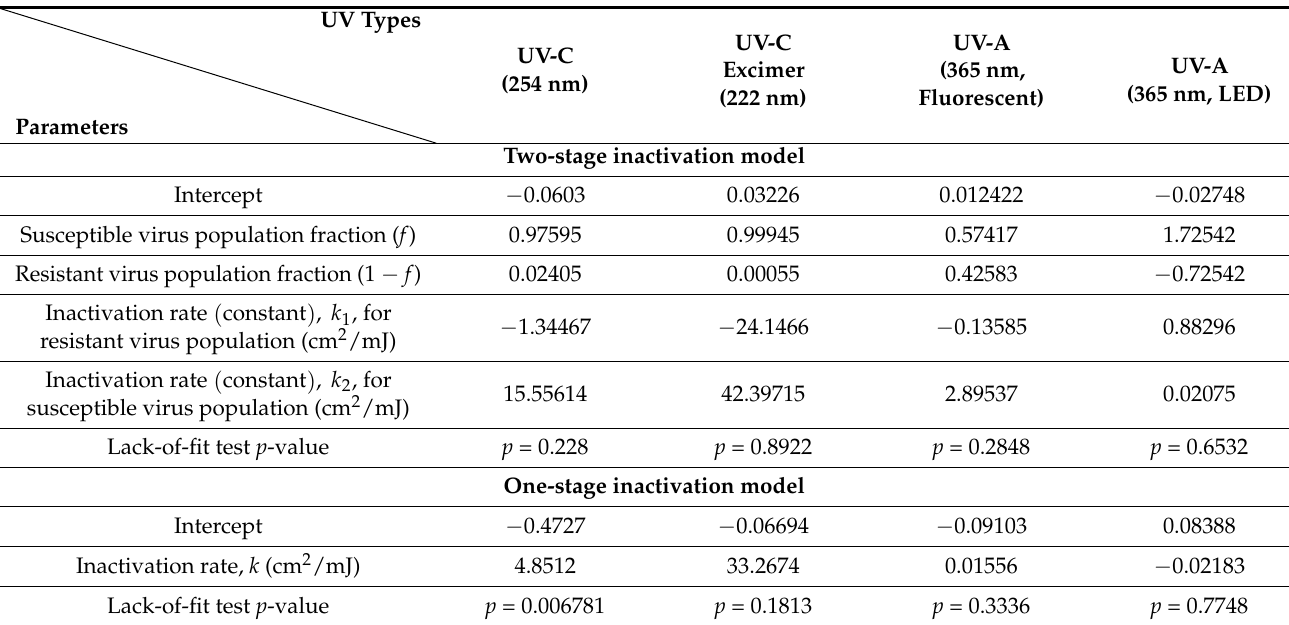
Table 2. One-stage and two-stage models, parameter estimations, and model parameters for inactiva- tion of airborne PRRSV with four types of UV light tested.